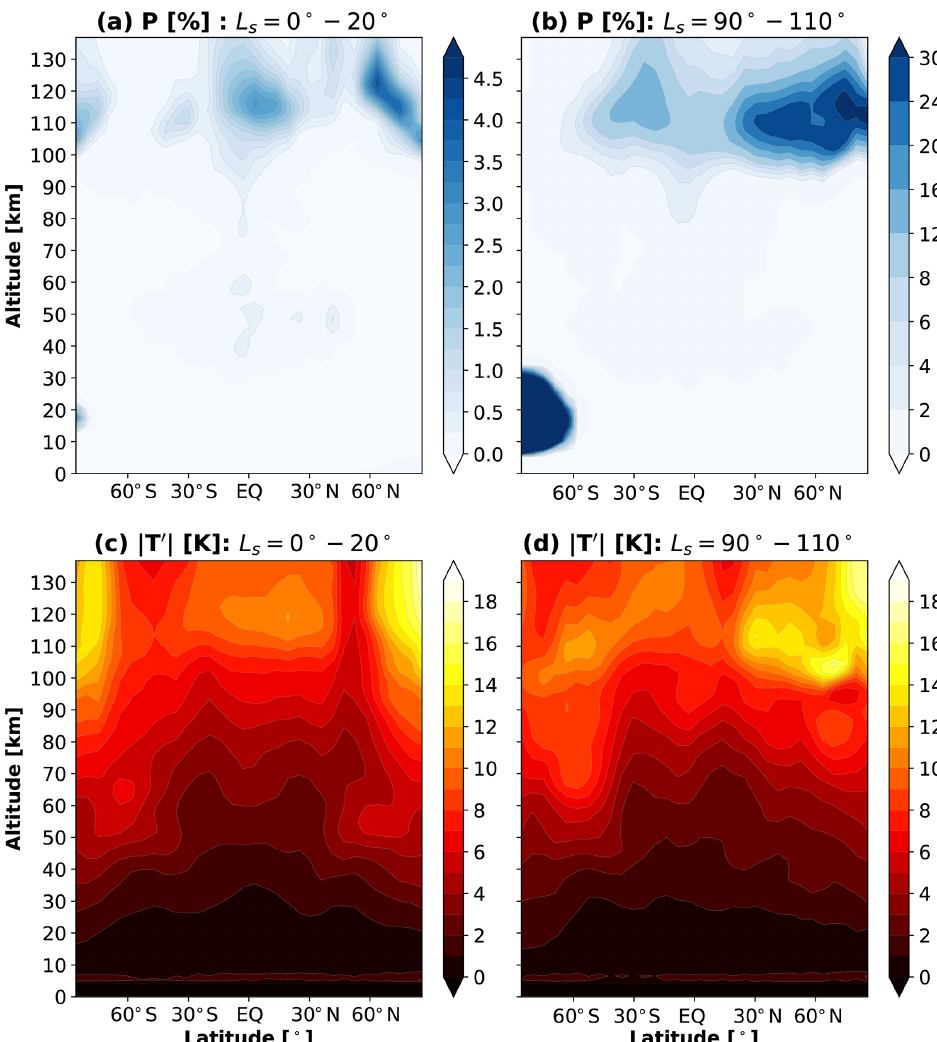
Figure 3. Altitude–latitude distributions of mean zonal mean cloud probability and gravity wave effects: (a) cloud probability ( P ) at equinox, (b) cloud probability at solstice, (c) gravity-wave-induced temperature fluctuations ( | T (cid:48) | = T (cid:48) temperature fluctuations at solstice. The fields are averaged over a period of L s = 0–20 ◦ (42 sols) for vernal equinox and over L s = 90–110 ◦ (44 sols) for Northern Hemisphere summer solstice seasons, i.e., in the same manner as the data presented in Fig. 2. Temperature fluctuations are in units of K and the probability is expressed in terms of